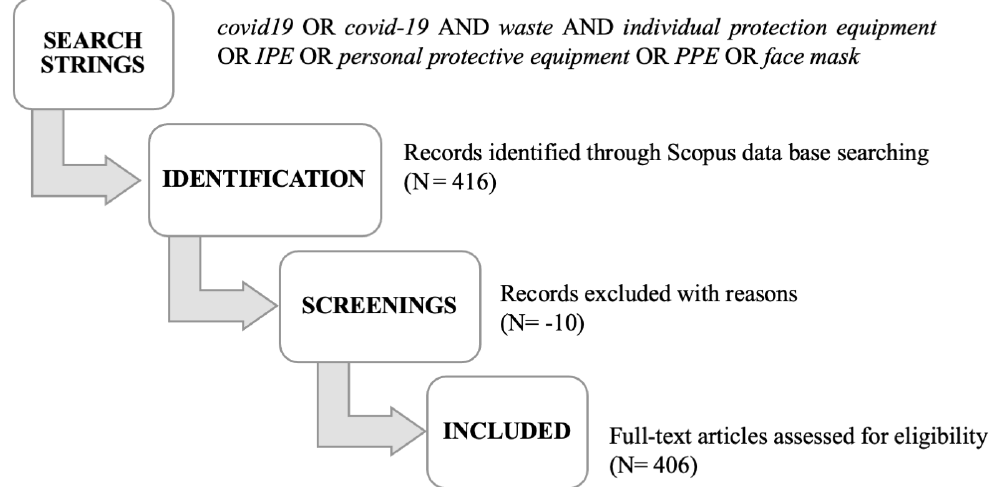
Figure 1. Steps followed to choose full-text included in bibliometric analysis in accordance with PRISMA flowchart